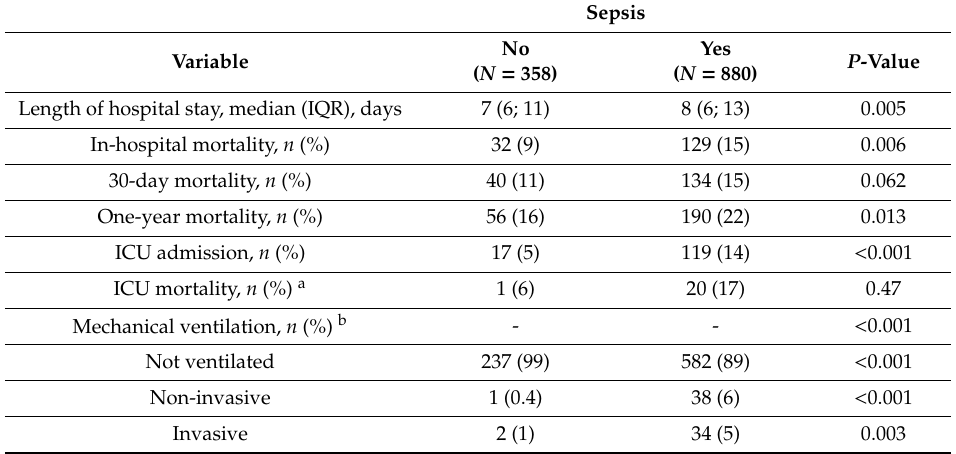
Table 3. Clinical outcomes according to